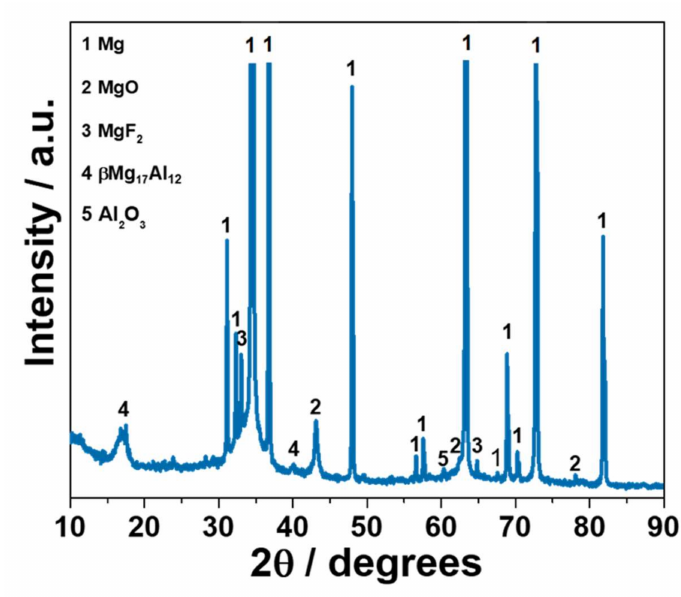
Figure 6. X-ray diffraction ( XRD) patterns of AlPF